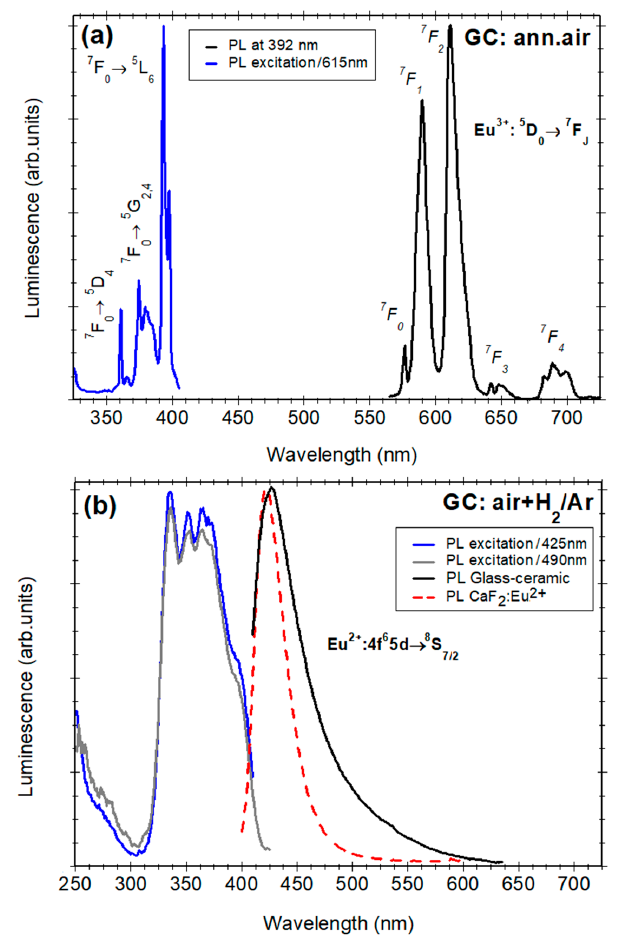
Figure 4. ( a ) Normalized photoluminescence spectrum recorded under 392 nm excitation and excitation spectrum of the 615 nm luminescence recorded on Eu 3+ -doped SiO 2 -CaF 2 glass-ceramics annealed in air; ( b ) photoluminescence spectrum recorded under 392 nm (or 365 nm) excitation and the excitation spectra of 420 and 490 nm luminescence recorded on the glass-ceramics annealed in reducing atmosphere. The photoluminescence spectrum of Eu 2+ -doped CaF 2 crystalline powder is shown for comparison (dotted